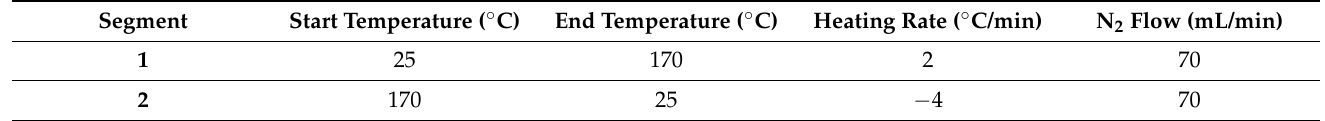
Table 7. (looped once to segment 1) DSC scanning program.